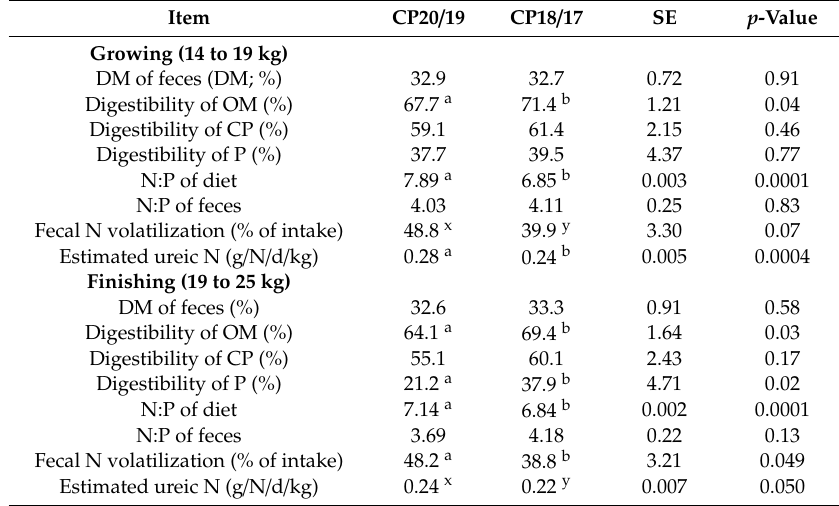
Table 7. E ff ect of Experimental Diets on Dry Matter (DM) of Feces, Apparent Digestibility of Organic Matter (OM), Crude Protein (CP) and Phosphorus (P), Nitrogen-Phosphorus Rate (N:P) of Diet, N:P of Feces, Volatilization of Nitrogen (N) and Estimated Ureic N.